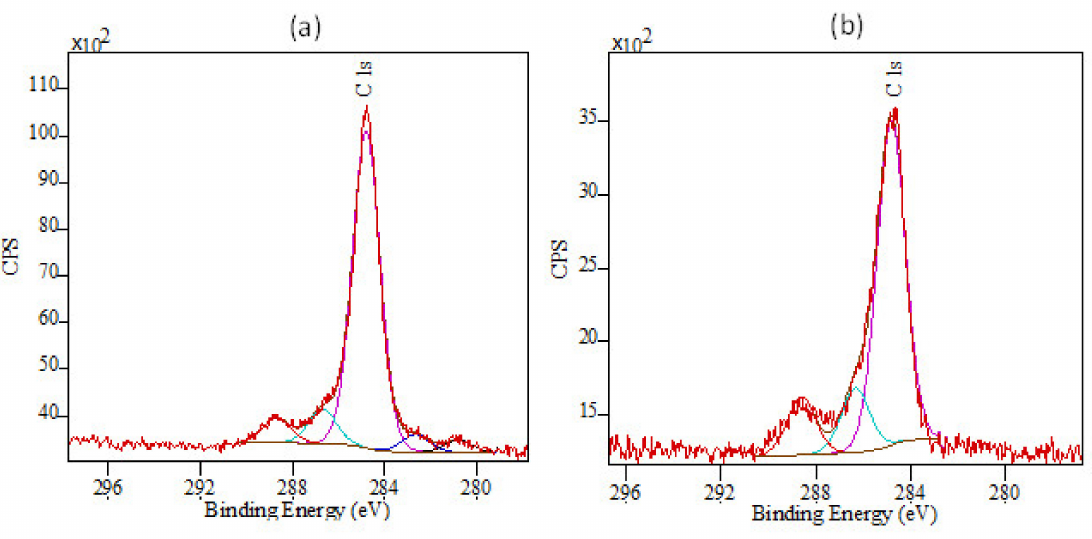
Figure 7. C1s XPS spectra of ( a ) the sample 2011-05-31-1-GaN listed in Table 1, grown under more gallium rich conditions, and ( b ) sample 2011-06-14-1-GaN, the AFM image of which is shown in Figure